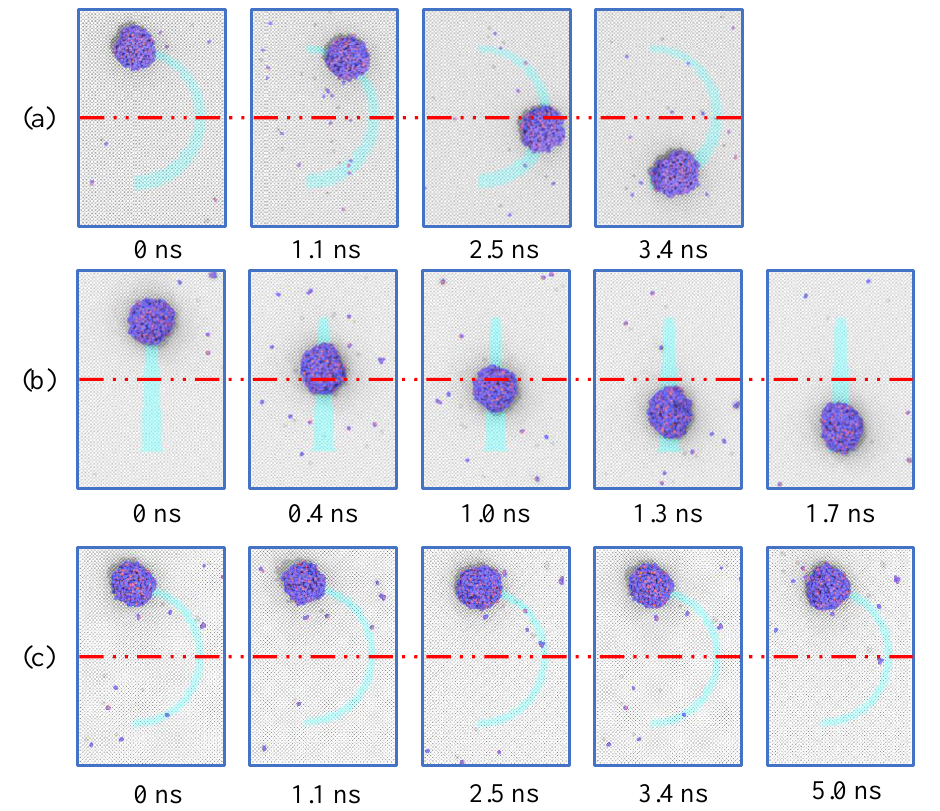
Figure 3. Snapshots of droplets on surfaces with patterns. ( a ) Curve track with width gradient. ( b ) Straight track with width gradient. ( c ) Curve track without width gradient. Red center line is marked to assist in observing droplet